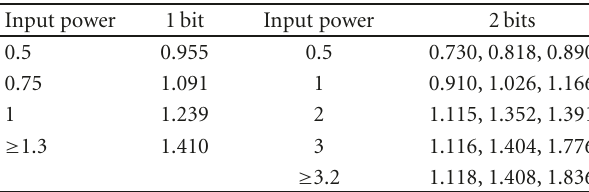
Table 6: Optimal quantization boundaries, unreliable quantization region detection, long-term power constraint, and CG distribution: Nakagami, μ = 2, w = 1, Pe = 0 . 2.